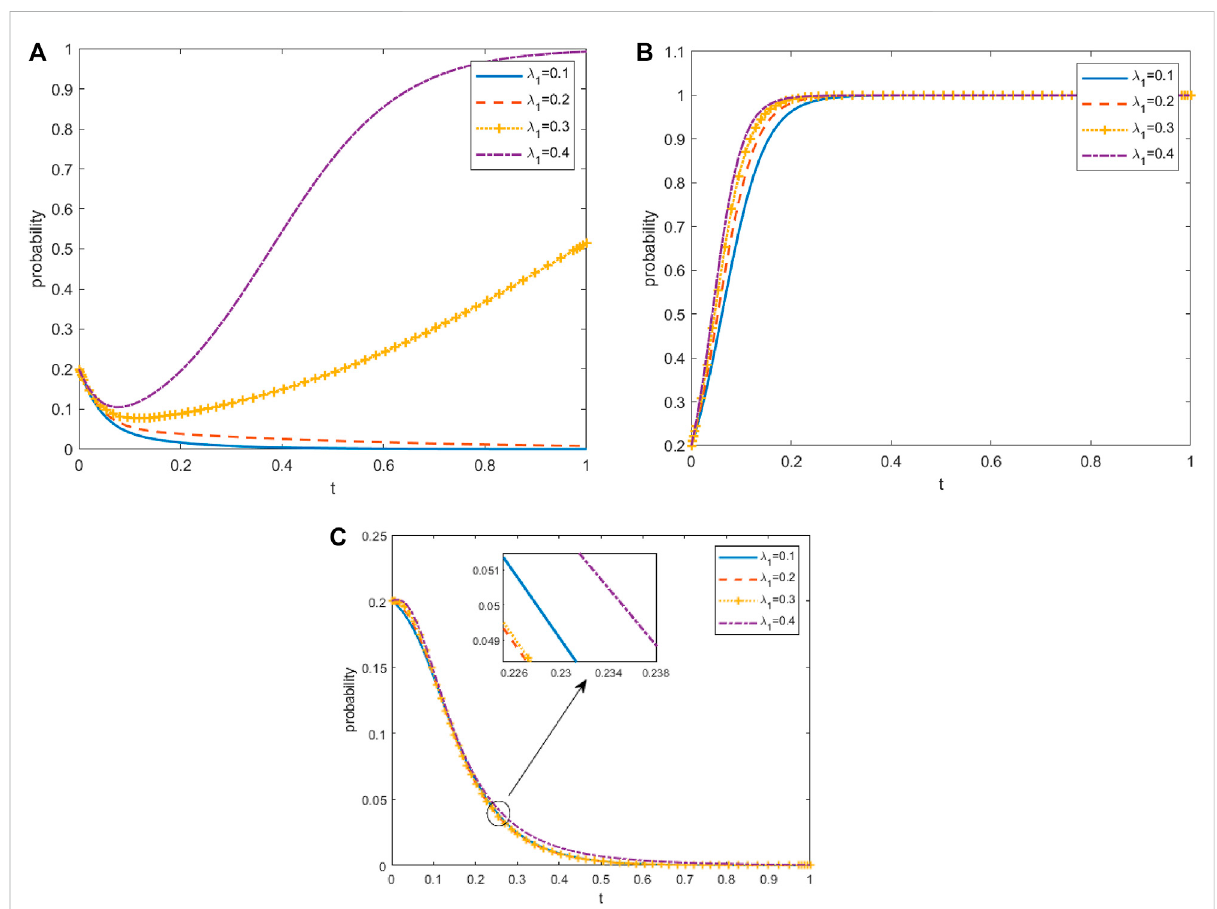
FIGURE 12 Effect of λ 1 ontheevolution ofthesystem. (A) Effect of λ 1 onfarmer ’ sstrategy, (B) Effect of λ 1 onthelocalgovernment ’ sstrategy, (C) Effect of λ 1 on the central government ’ s